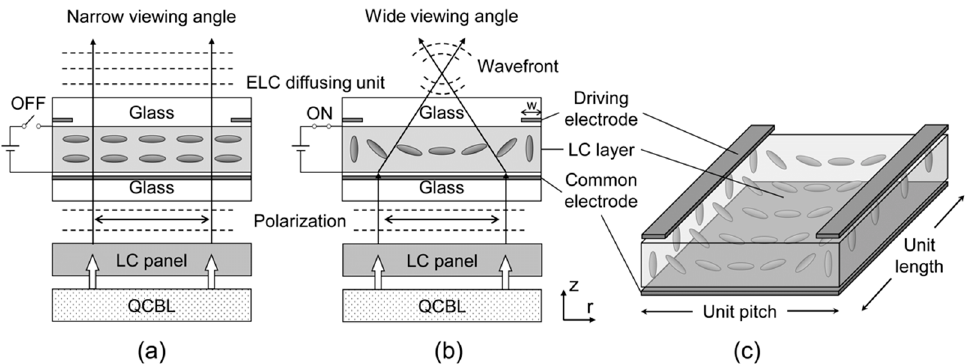
Figure 1. Diagrams of the liquid crystal display (LCD) system equipped with an electric-field-driven liquid crystal (ELC) diffusing unit: ( a ) Narrow-view mode when the ELC diffusing unit is off and ( b ) wide-view mode when the ELC diffusing unit is on. ( c ) Schematic diagram of the ELC diffusing unit. The liquid crystal (LC) molecules have different behaviors depending on the voltages applied between the driving electrode with the width of w and the common electrode of the bottom glass.